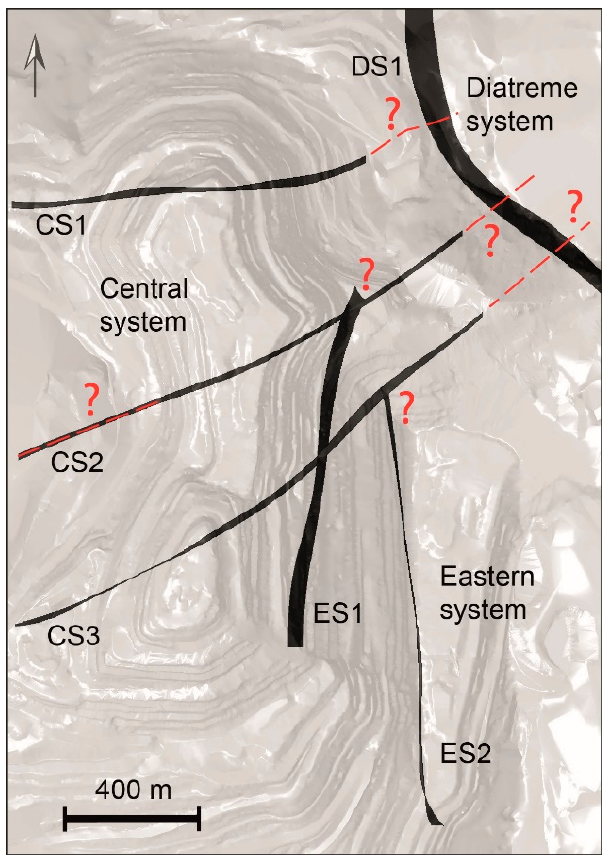
Figure 6. The schematic representation of the structural model currently used, showing the recognized principal faults. The main issues on the model are pointed out by question marks. CS: Central System Faults 1, 2 and 3; ES: Eastern System Faults 1 and 2; DS: Diatreme System Fault.